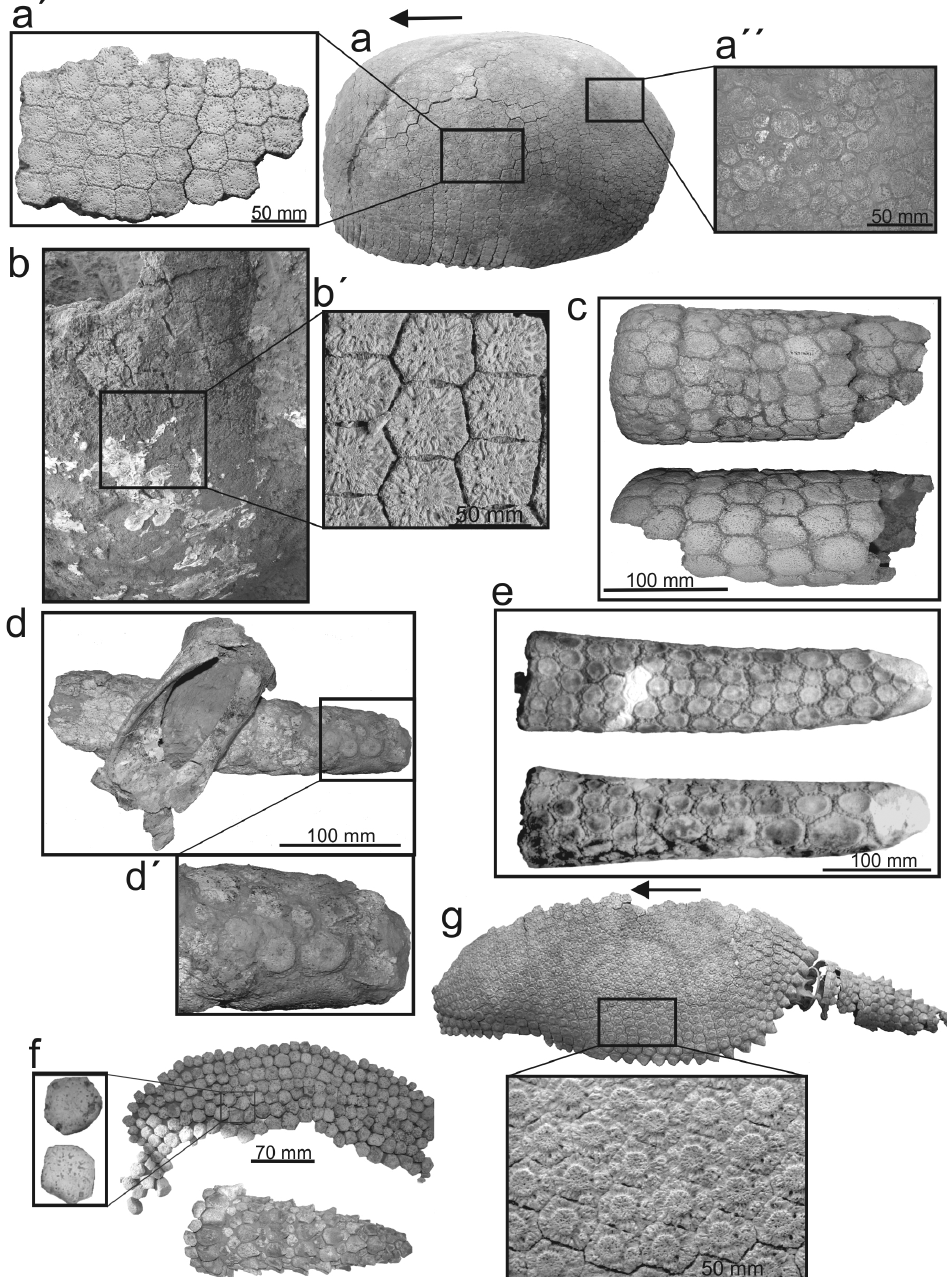
Figure 4 - Eosclerocalyptus cf. lineatus (Xen 30). a, dorsal carapace in lateral view; a ´ , detail of the exposed surface of the osteoderms showing a clear Lomaphorus / Urotherium / Trachycalyptus ornamentation pattern; a ´´ , detail of the exposed surface of the osteoderms showing a “rosette” ornamentation pattern; b, Eosclerocalyptus sp., dorsal carapace showing the taphonomic alteration of its exposed surface ( b ´); c, Eosclerocalyptus cf. lineatus (Xen 30), proximal half of caudal tube showing a Lomaphorus / Urotherium pattern; d, Neosclerocalyptus (GCF 83) , caudal tube belonging to a juvenile specimen; d ´, detail of the distal portion showing the particular morphology; e , Neosclerocalyptus ornatus (MMP 4600), caudal tube in dorsal and ventral views showing the similitude with the caudal tube assigned to Lomaphorus; f, Glyptodon (PVF 85), associated osteoderms and caudal armor belonging to an early juvenile stage; g, Glyptodon reticulatus (MCA 2017), dorsal carapace belonging to a juvenile specimen showing the morphology of the lateral